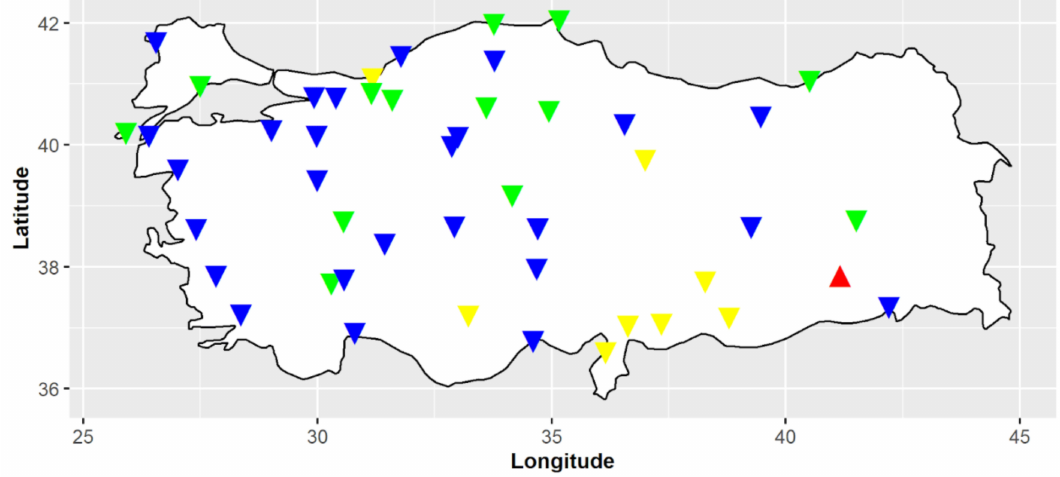
Figure A19. Same as Figure A13 but for June (See Figure A13 for